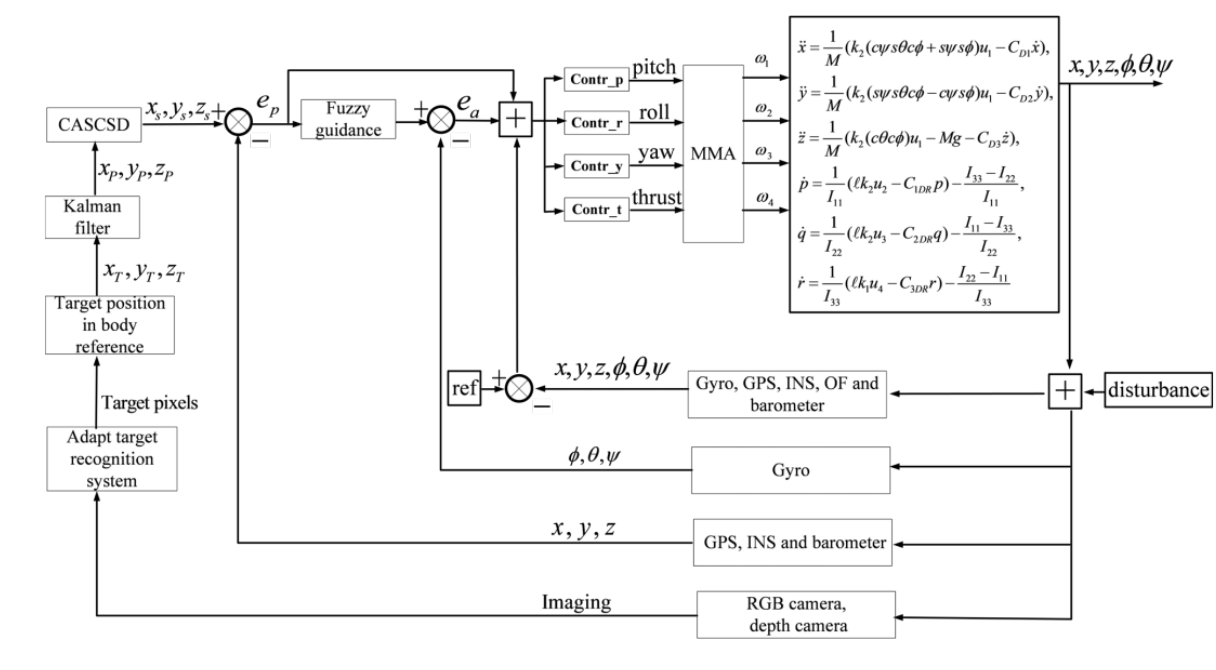
Figure 11. The flight control system.